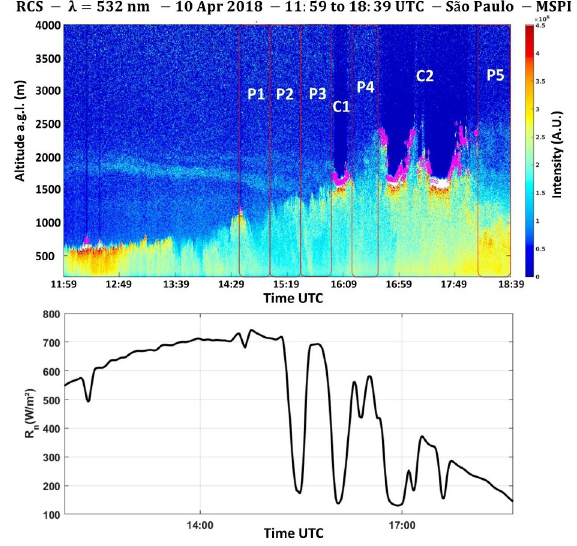
Figure 1: RCS at 532 nm retrieved by lidar station at 10 th of April of 2018 showing the clouds altitude, and below, the pyranometer profile showing radiation blockage by